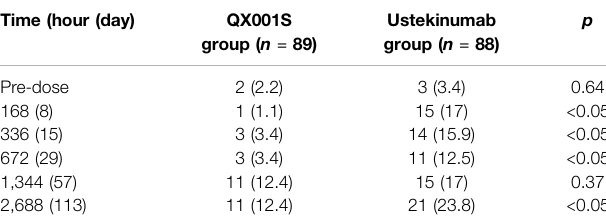
TABLE 3 | Summary of immunogenicity (anti-drug antibody, ADA) assessment (number [%] of participants with positive ADA). Time (hour (day)